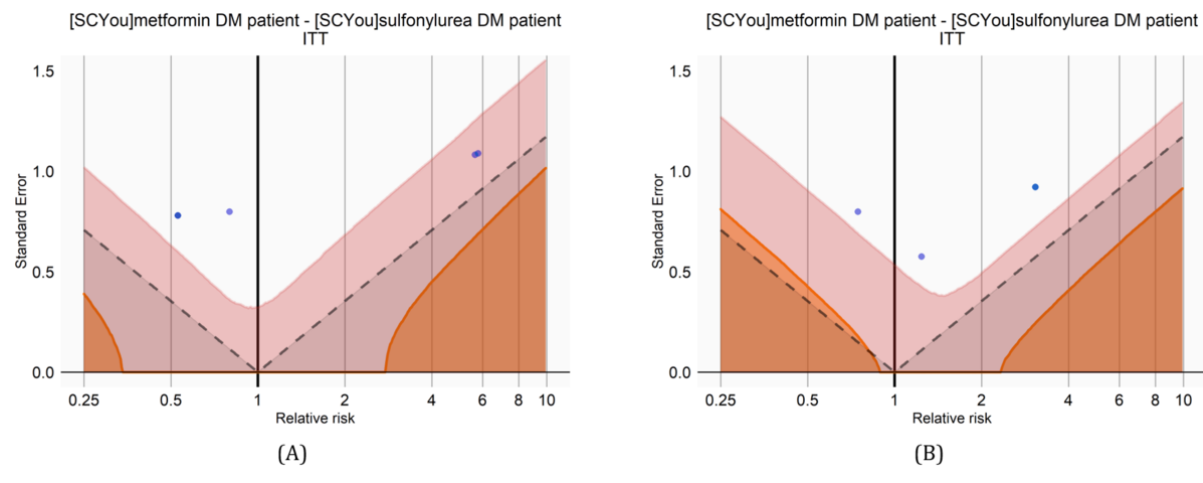
Figure 2. Null distributions for the “MetforminVsSulfonylurea” study (A) without de-identification and (B) with the proposed de-identification strategy. ITT: